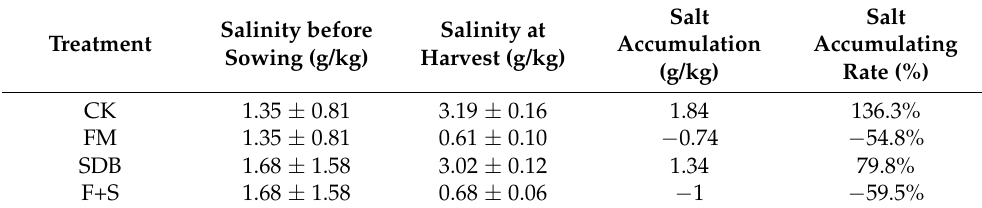
Table 4. The soil salinity dynamics under each